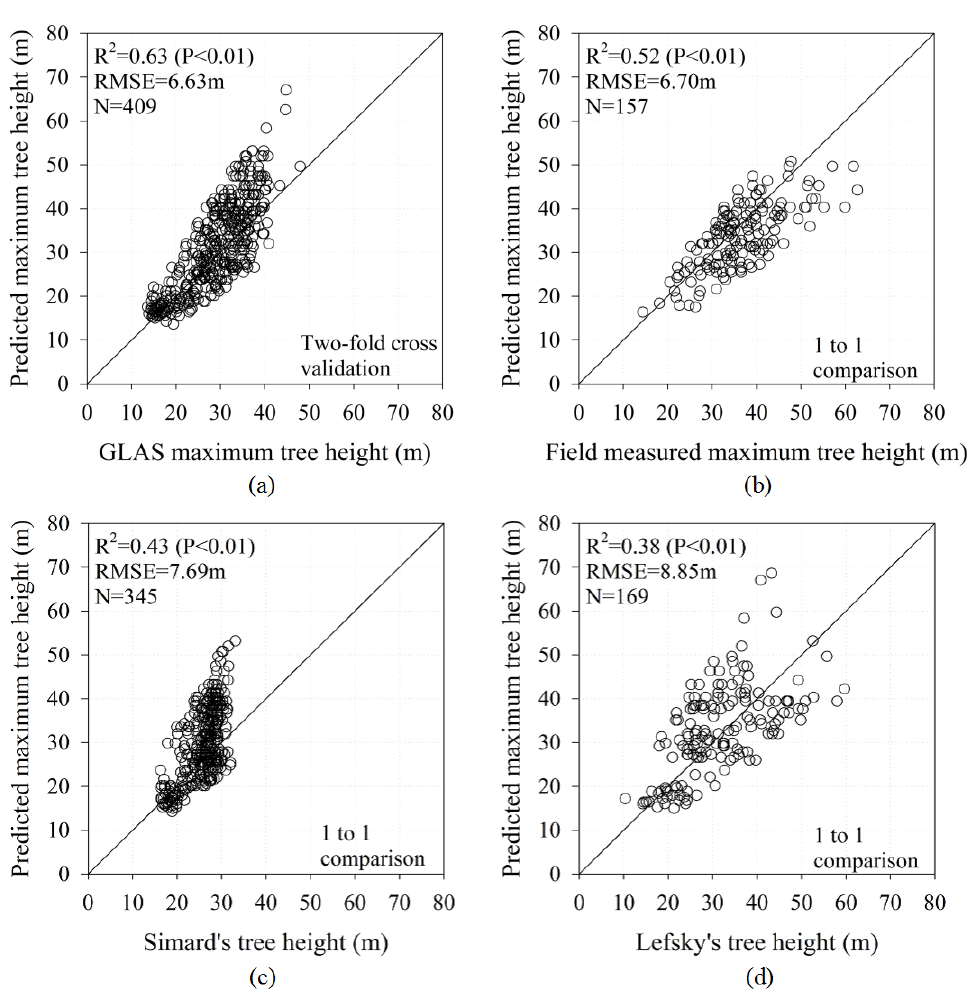
Figure 5. Comparisons between the predicted tree height and test GLAS altimetry dataset over the CONNA. ( a ) Two-fold cross validation between the GLAS height and ASRL model prediction (409 effective climatic zones); ( b ) comparison between the field-measured height and ASRL model prediction (157 effective climatic zones); ( c , d ) inter-comparisons between the ASRL predictions and Simard’s and Lefsky’s height estimations,